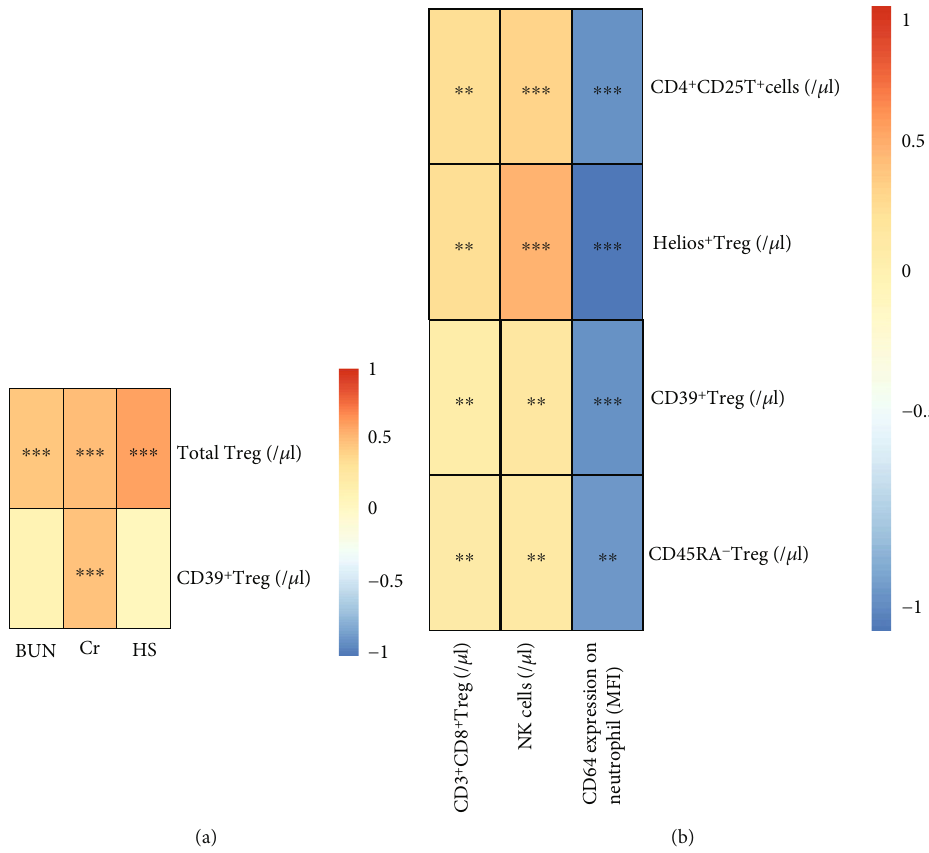
Figure 4: Correlation analysis of Treg subpopulations with clinical information and regular immune status. (a) The heatmap of the correlations between di ff erent Treg subpopulations and the clinical information of the patients. (b) The heatmap of the correlations between di ff erent Treg subpopulations and the regular immune indexes of the patients. HS: hospital stay period (days); BUN: blood urea nitrogen; Cr: serum creatinine. Red indicates positive correlations while blue indicates negative ones. ∗∗∗ means P < 0 : 01 , ∗∗ means P < 0 : 05 , and ∗ means P < 0 : 1